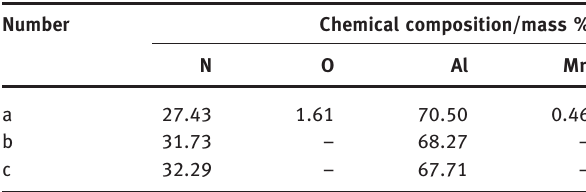
Table 2: Chemical composition of AlN particles in Figure